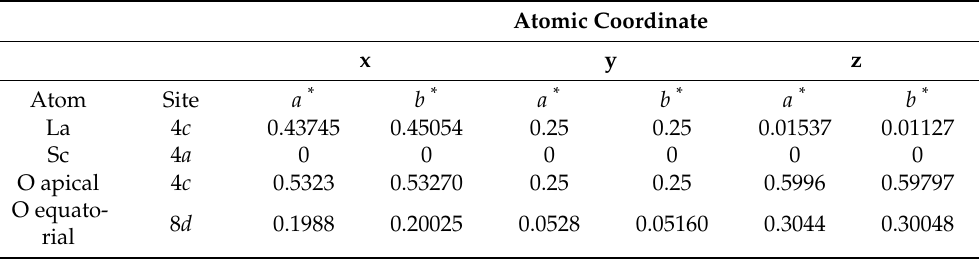
Table A1. Atomic coordinates of LaScO 3 .